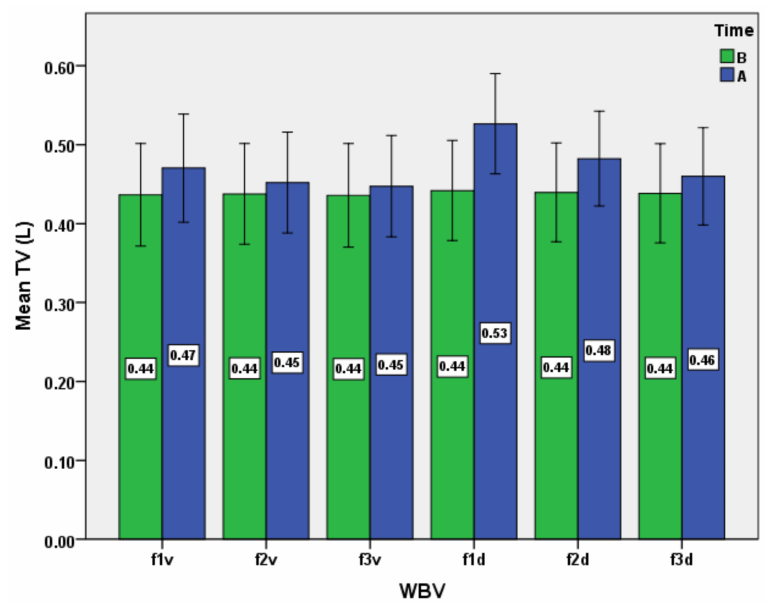
Figure 2. Impact of the WBV exposure on tidal volume (TV) for the six protocols (means and standard deviations). B, before; A, after.